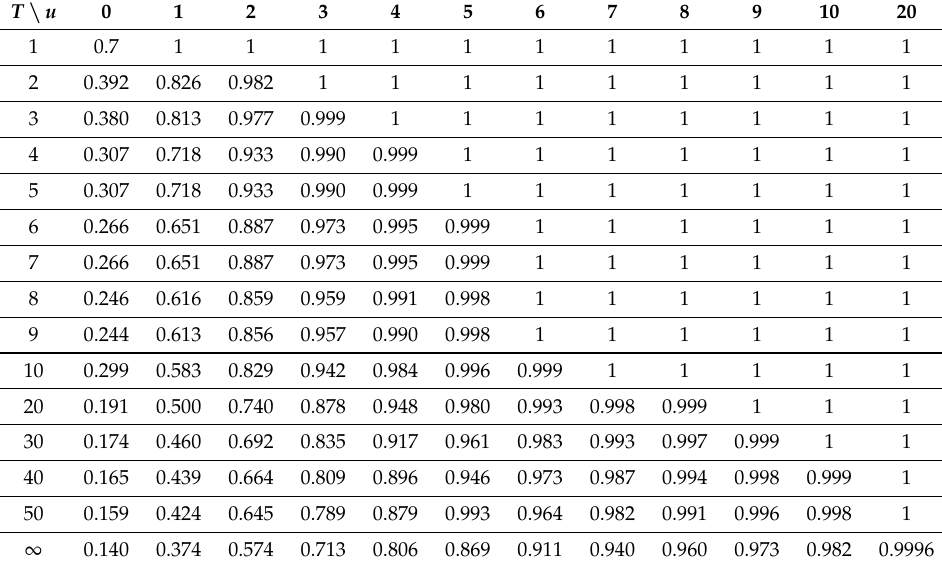
Table 11. Values of survival probabilities for the model described in Example